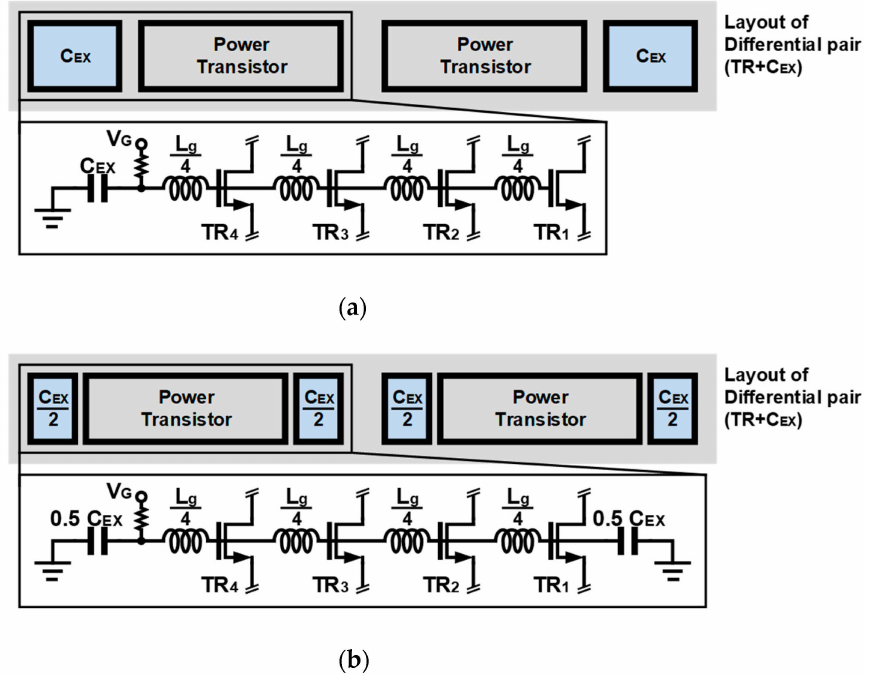
Figure 7. Conceptual layout of the differential power transistor with neutralization capacitor: ( a ) typical and ( b ) proposed layout techniques.